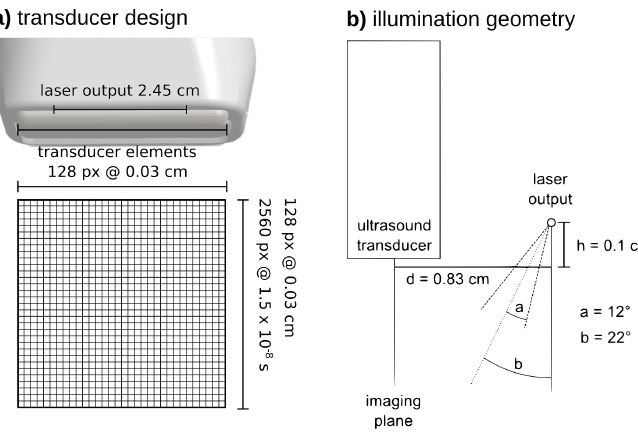
Figure 4. Depiction of the illumination geometry and the transducer design which is based on our Fraunhofer DiPhAS photoacoustic imaging (PAI) system [54]. ( a ) The ultrasound transducer design with the position of the laser output and the transducer elements, as well as the imaging plane; ( b ) one-half of the symmetric transducer design, where the laser outputs are in parallel left and right to the transducer elements over a length of 2.45